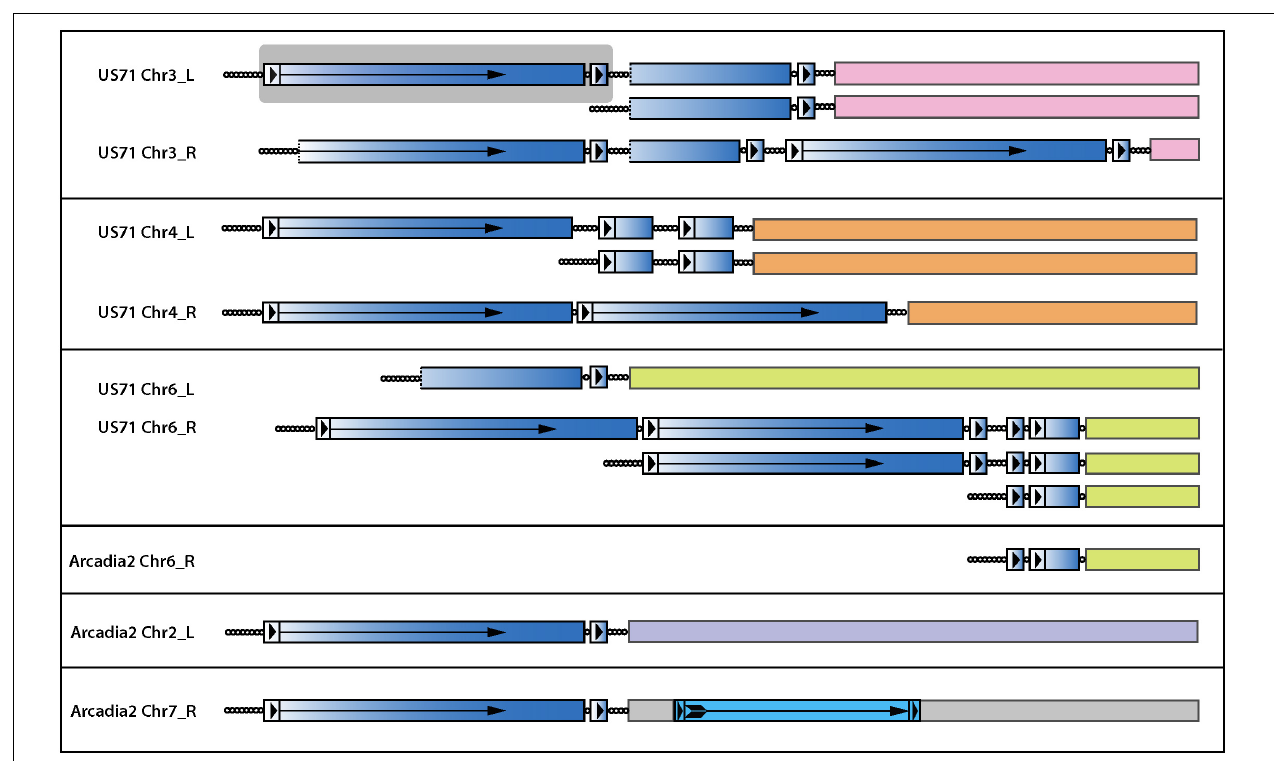
FIGURE 7 | Interstitial telomere sequences define the boundaries of subtelomeric tandem repeats in the foxtail pathogens. The figure shows the organization of all interstitial telomeres identified in the Arcadia2 and US71 genomes. Full-length and partial copies of an associated tandem repeat are shaded with a blue gradient shading to illustrate the origin of partial repeat sequences and dotted lines indicate truncations ends. Long terminal repeat (LTR)-like structures are shown as boxes with arrowheads, and the reverse-transcriptase coding regions is marked with an arrow. A full-length repeat with LTRs is highlighted with a gray background. A bona-fide LTR retrotransposon insertion in Arcadia2 Chr7 is shown with lighter blue shading. Interstitial telomere sequences are shown as circles, with each circle representing approximately four CCCTAA repeat motifs. Truncated variants detected among MinION raw reads are illustrated beneath the respective main chromosome end